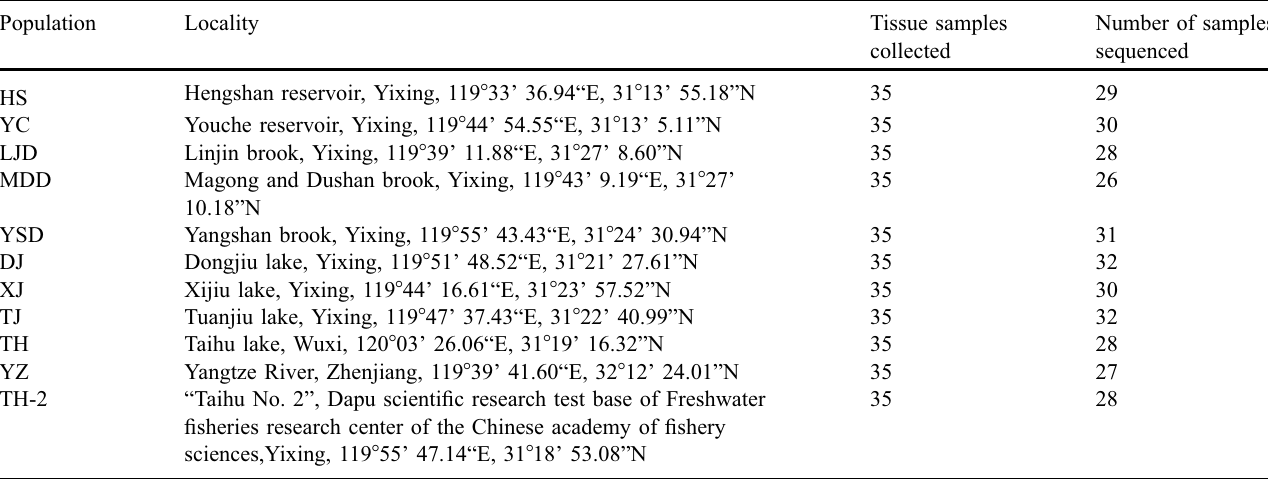
Table 1. Information of populations of M. nipponense included in the present research. Population Locality Tissue samples